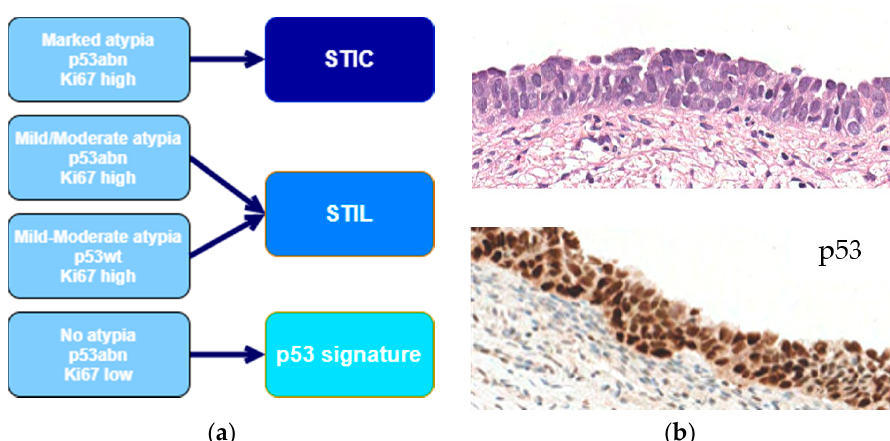
Figure 3. ( a ) Diagnostic algorithm to classify tubal lesions (adapted from R. Vang et al.). abn: abnormal; STIC: serous tubal intraepithelial carcinoma; STIL: serous tubal intraepithelial lesion; wt: wild type. ( b ) An example of STIC (top: marked nuclear atypia, hematoxylin-eosin, x400; bottom: p53-overexpression, DO7 clone, x400).